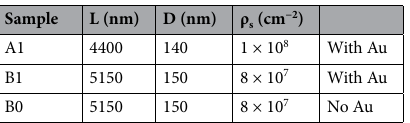
Table 1. Characteristic geometric parameters for the three samples.